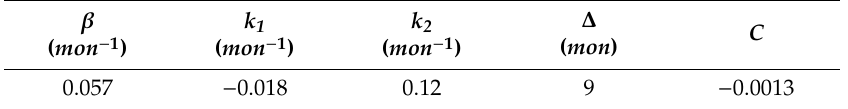
Table 3. Coe ffi cient values of β , k 1 , k 2 , and C for Equation (7), where mon stands for month.